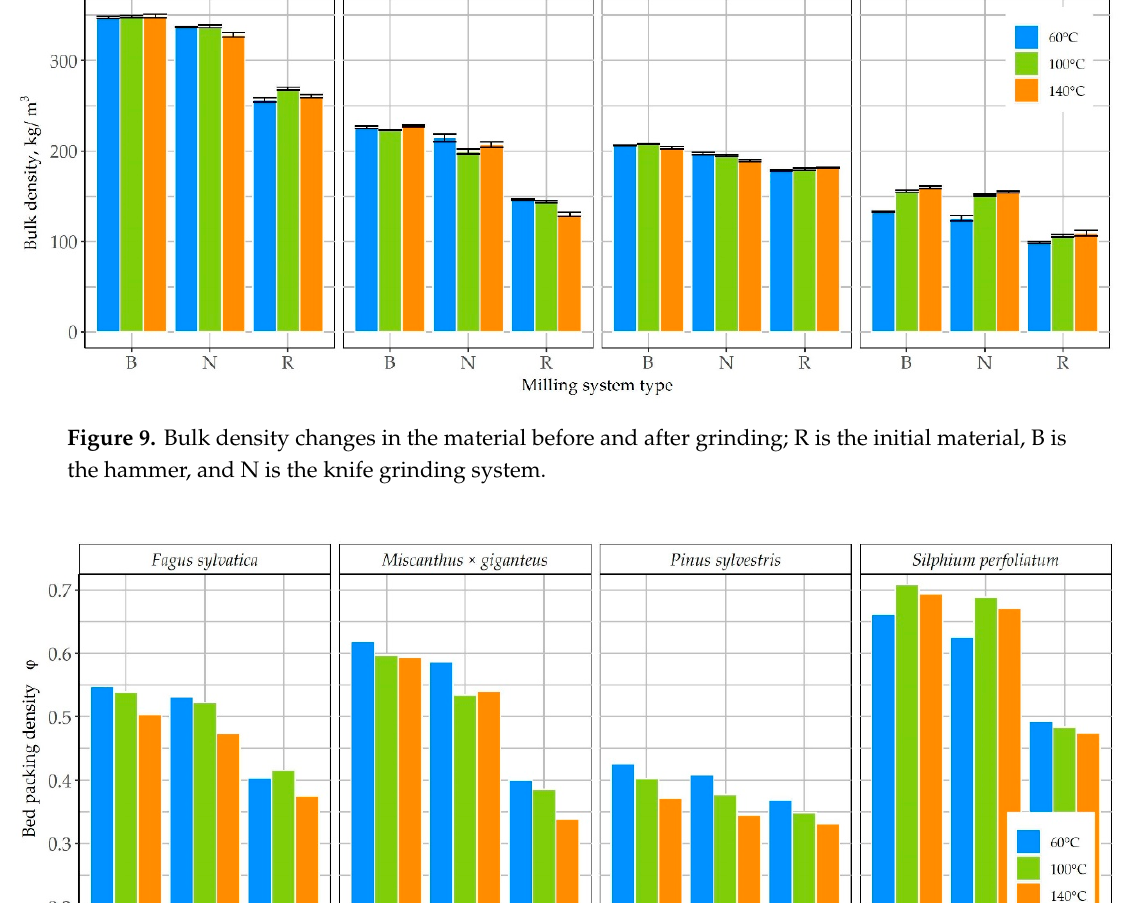
Table 3. Raw material specific density DE (g/cm 3 ).